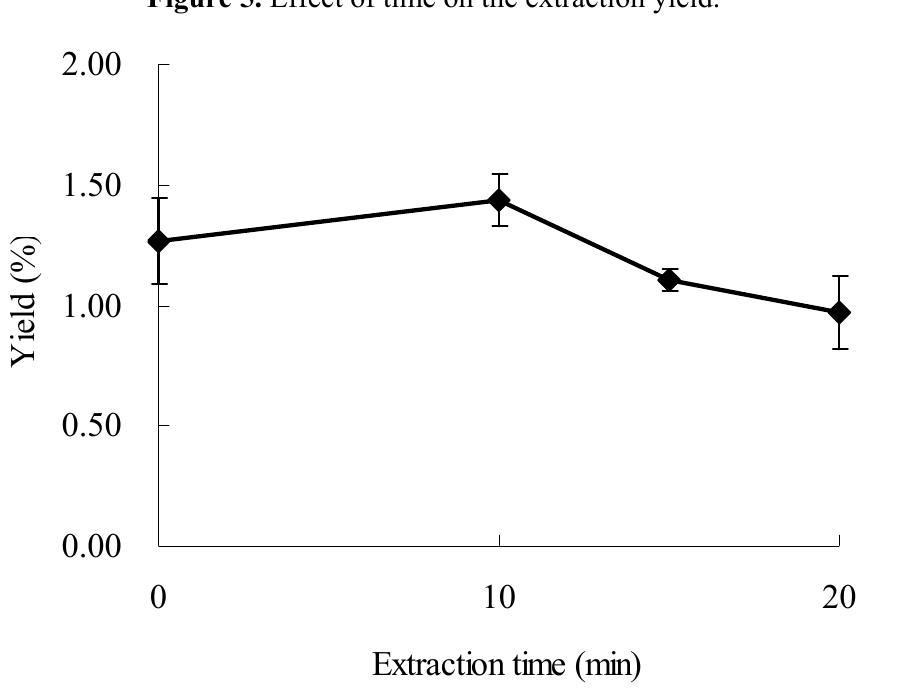
Figure 5. Effect of time on the extraction